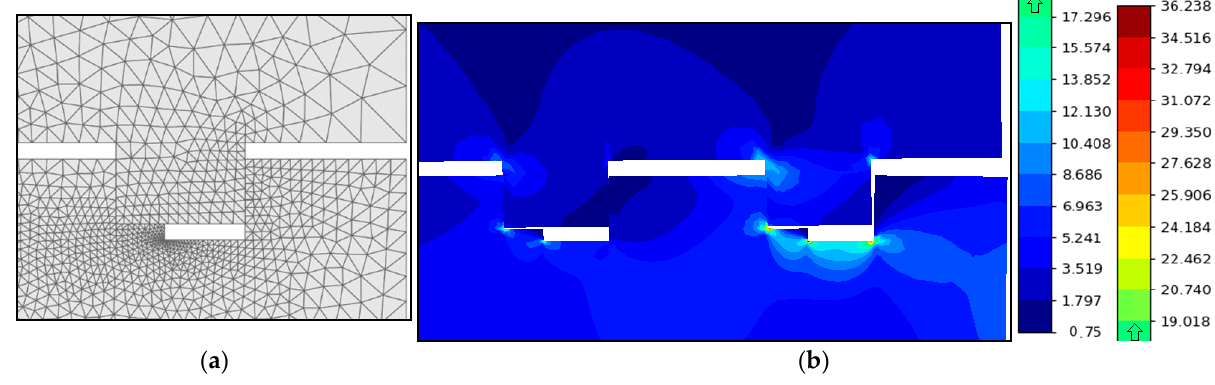
Figure 4. Finite element mesh ( a ) and distribution of equivalent stresses ( b ) in the zone of the first thread turns (MPa).